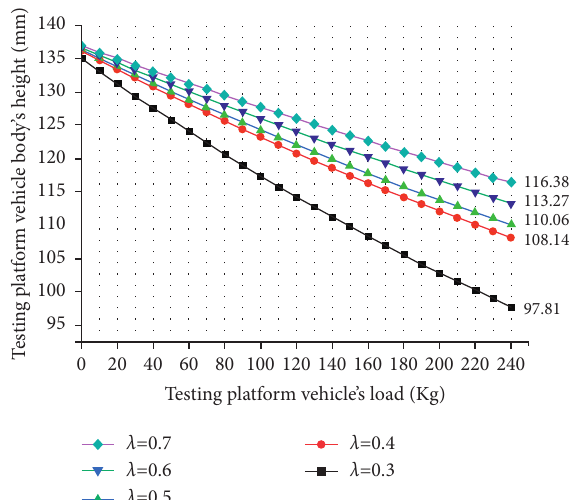
Figure 17: Sensitivity analysis results of the vehicle’s body height versus the loading conditions under different suspension installation locations.